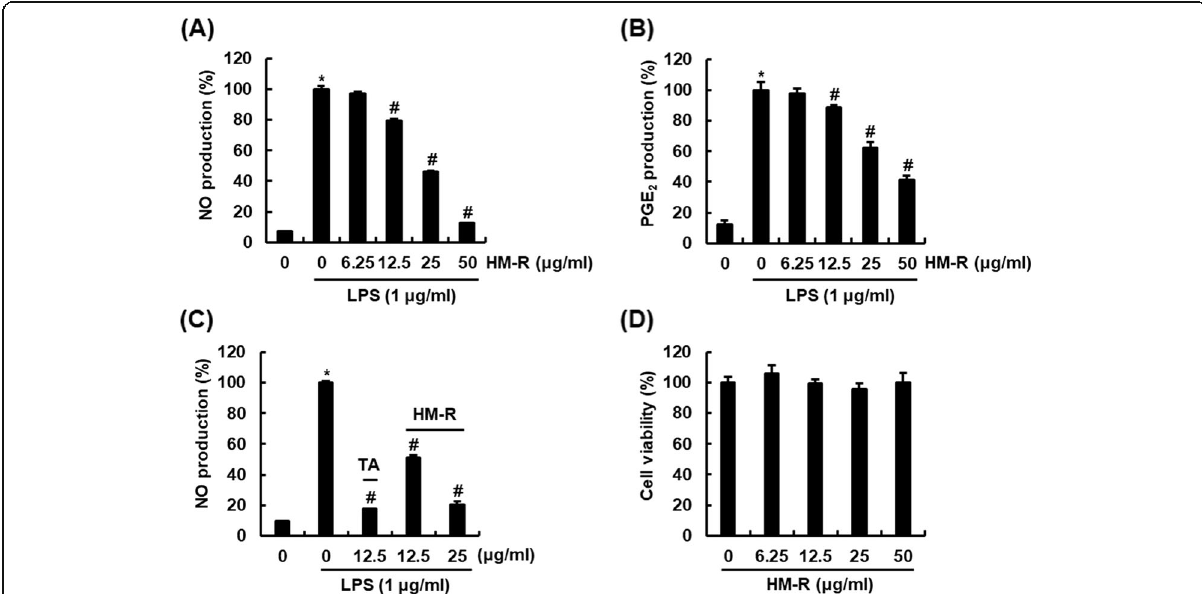
Fig. 1 Inhibitory effect of HM-R against NO and PGE 2 production in LPS-stimulated RAW264.7 cells. a and b RAW264.7 cells were pretreated with HM-R for 2 h and then co-treated with LPS (1 μ g/ml) for 18 h. NO and PGE 2 production was measured by Griess assay and Prostaglandin E 2 ELISA Kit, respectively. c RAW264.7 cells were pretreated with HM-R or TA for 2 h and then co-treated with LPS (1 μ g/ml) for 18 h. NO production was measured by Griess assay. d RAW264.7 cells were treated with HM-R for 24 h. Cell viability was measured by MTT assay. * P < 0.05 compared to the cells without the treatment, and # P < 0.05 compared to the cells treated with LPS